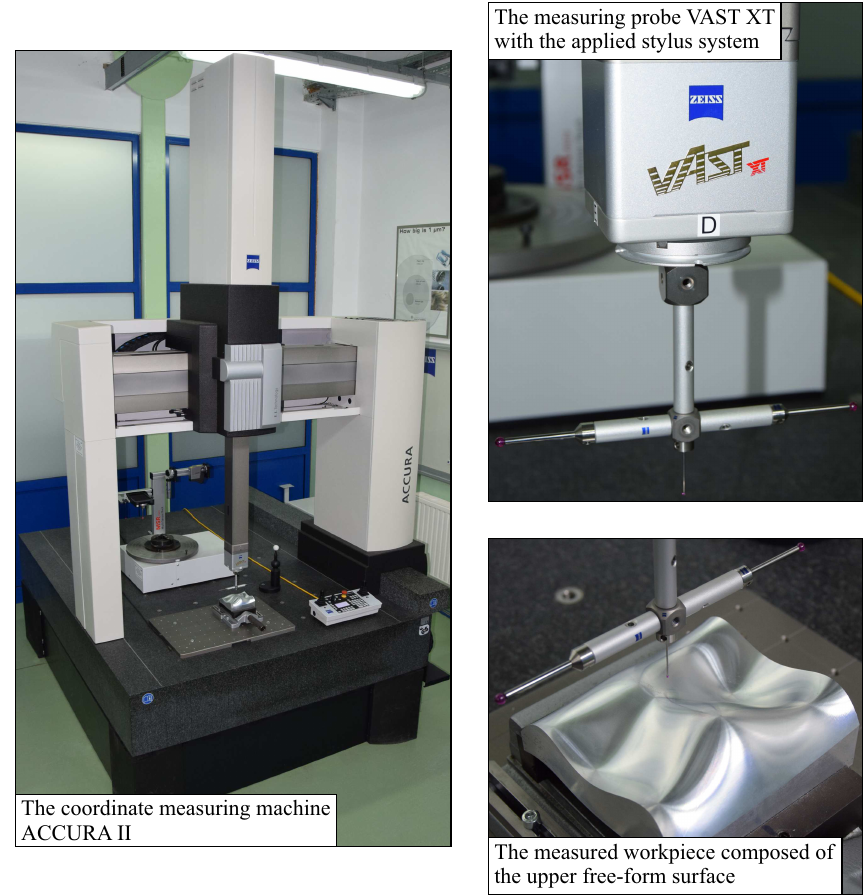
Figure 14. The applied measuring system used and the measured free-form